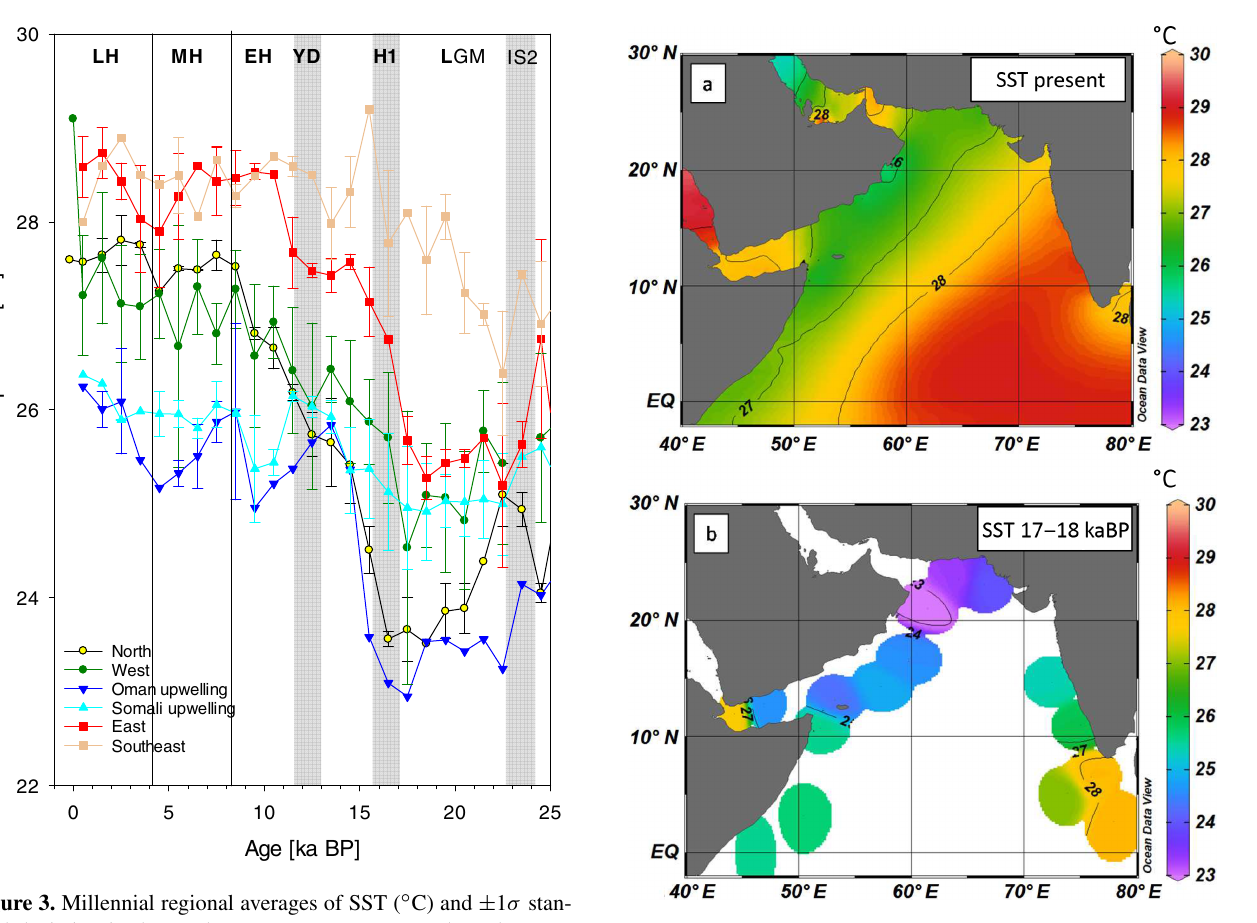
Figure 4. Annual SST distribution in ◦ C from the World Ocean Atlas (Locarnini et al., 2013) (a) ; alkenone- and Mg / Ca-derived SST reconstruction for the time slice from 17–18kaBP (b) from cores shown in Fig.